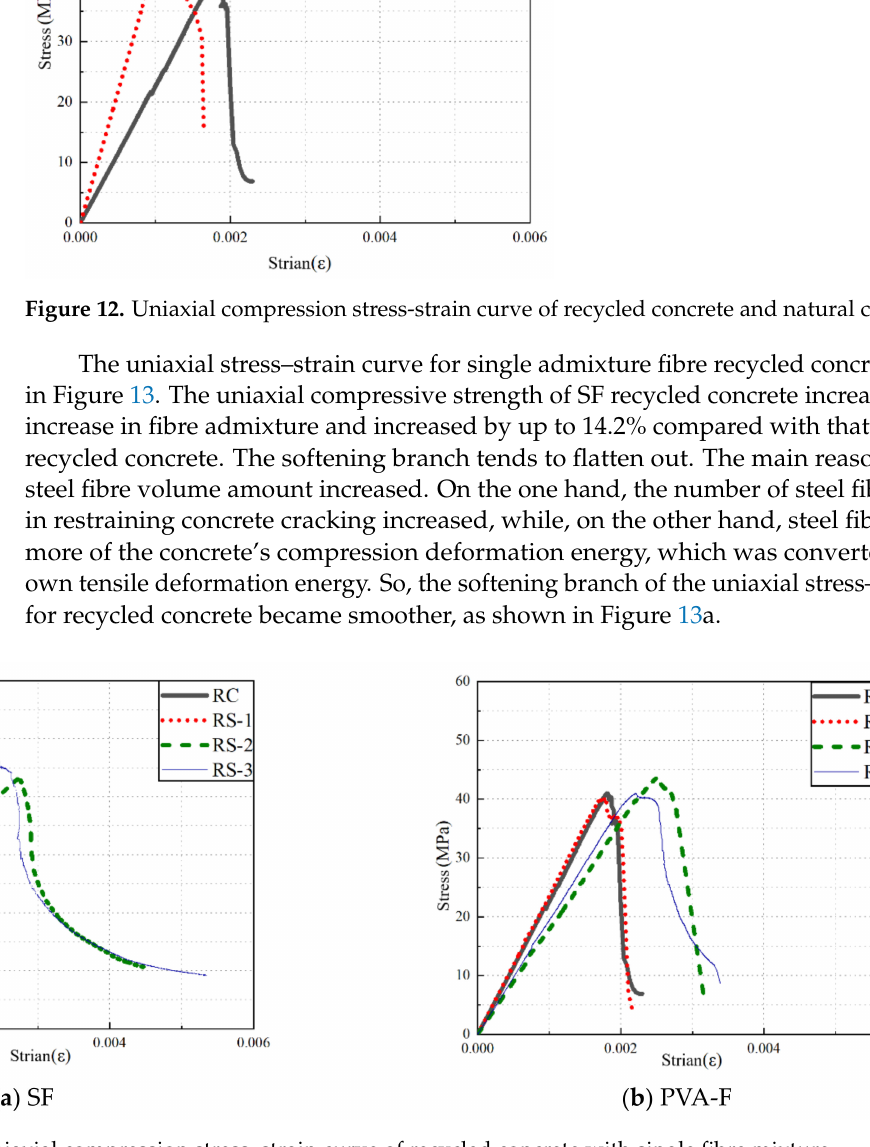
Figure 13. Uniaxial compression stress–strain curve of recycled concrete with single fibre mixture. As can be seen from Figure 13b, the difference between the RP-1 stress–strain curve and the RC was not significant, indicating that a small amount of polyvinyl alcohol fibre admixture had a small effect on the uniaxial compressive stress–strain behaviour of the recycled concrete. Comparing the curves of RP-1, RP-2, and RP-3, it can be seen that as the volume admixture of polyvinyl alcohol fibre increased, the uniaxial compressive strength and the peak strain first increased and then decreased, and the softening branch of the stress–strain curve tended to flatten from a steep drop. This indicates that the deformation capacity and the energy absorption capacity of the specimens increased during the stress- softening stage. The reason for this is that more polyvinyl alcohol fibre was used to link the cracked surfaces of the recycled concrete, improving the bond of the cracked surface of concrete. Thus, more energy was required to deform the specimen by